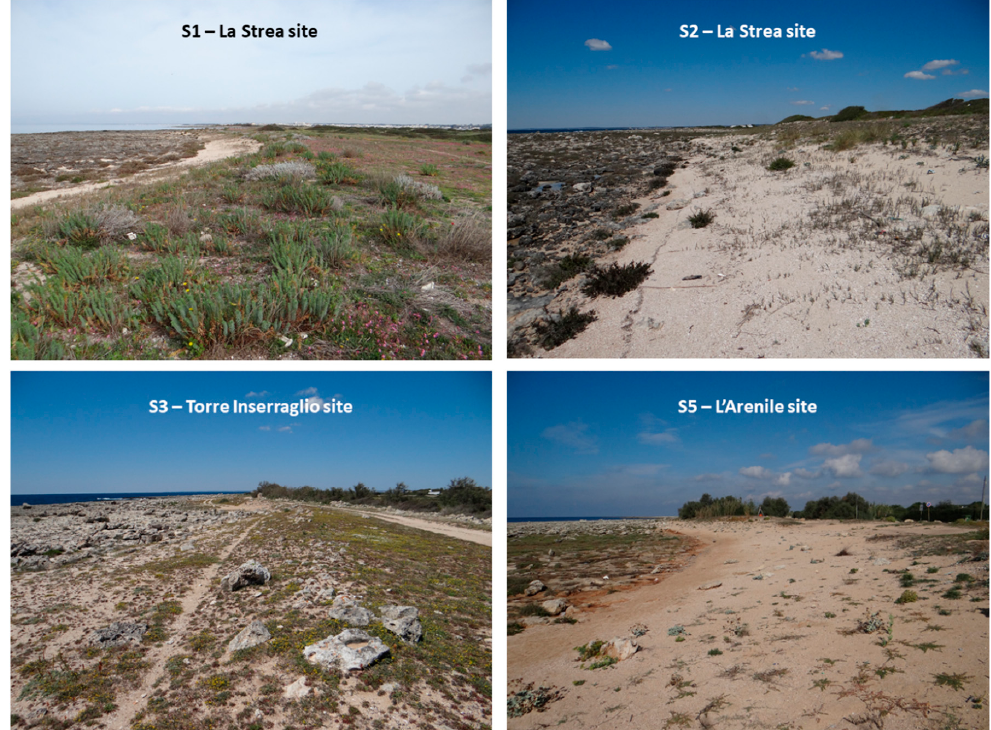
Figure 8. Views of the coastal sand ridge at different sites. Sea is at left (west side), land at right (east side). The sand ridge surface is vegetated except at the foot of its seaward slope, reached by storm waves responsible for the deposition of a low storm berm.